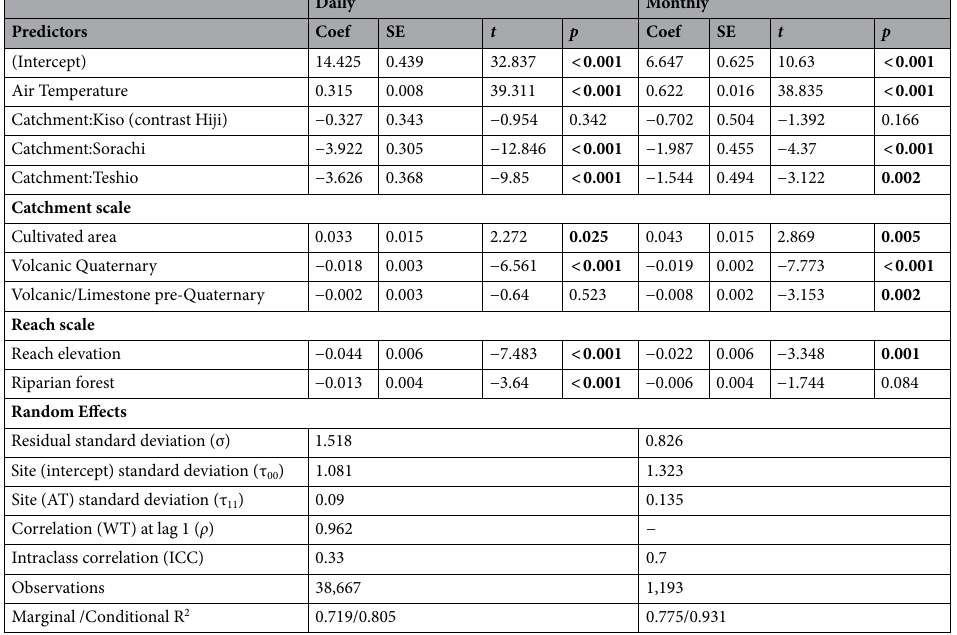
Table 2. Summary of the results for the linear mixed effects models fitting water temperature to air temperature and a suite of landscape and reach scale environmental covariates at the two timescales. Significant values are in